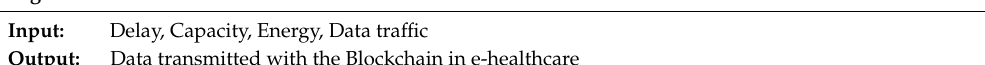
Proposed Algorithm Algorithm for Blockchain-based smart contracts for IoMT in e-healthcare